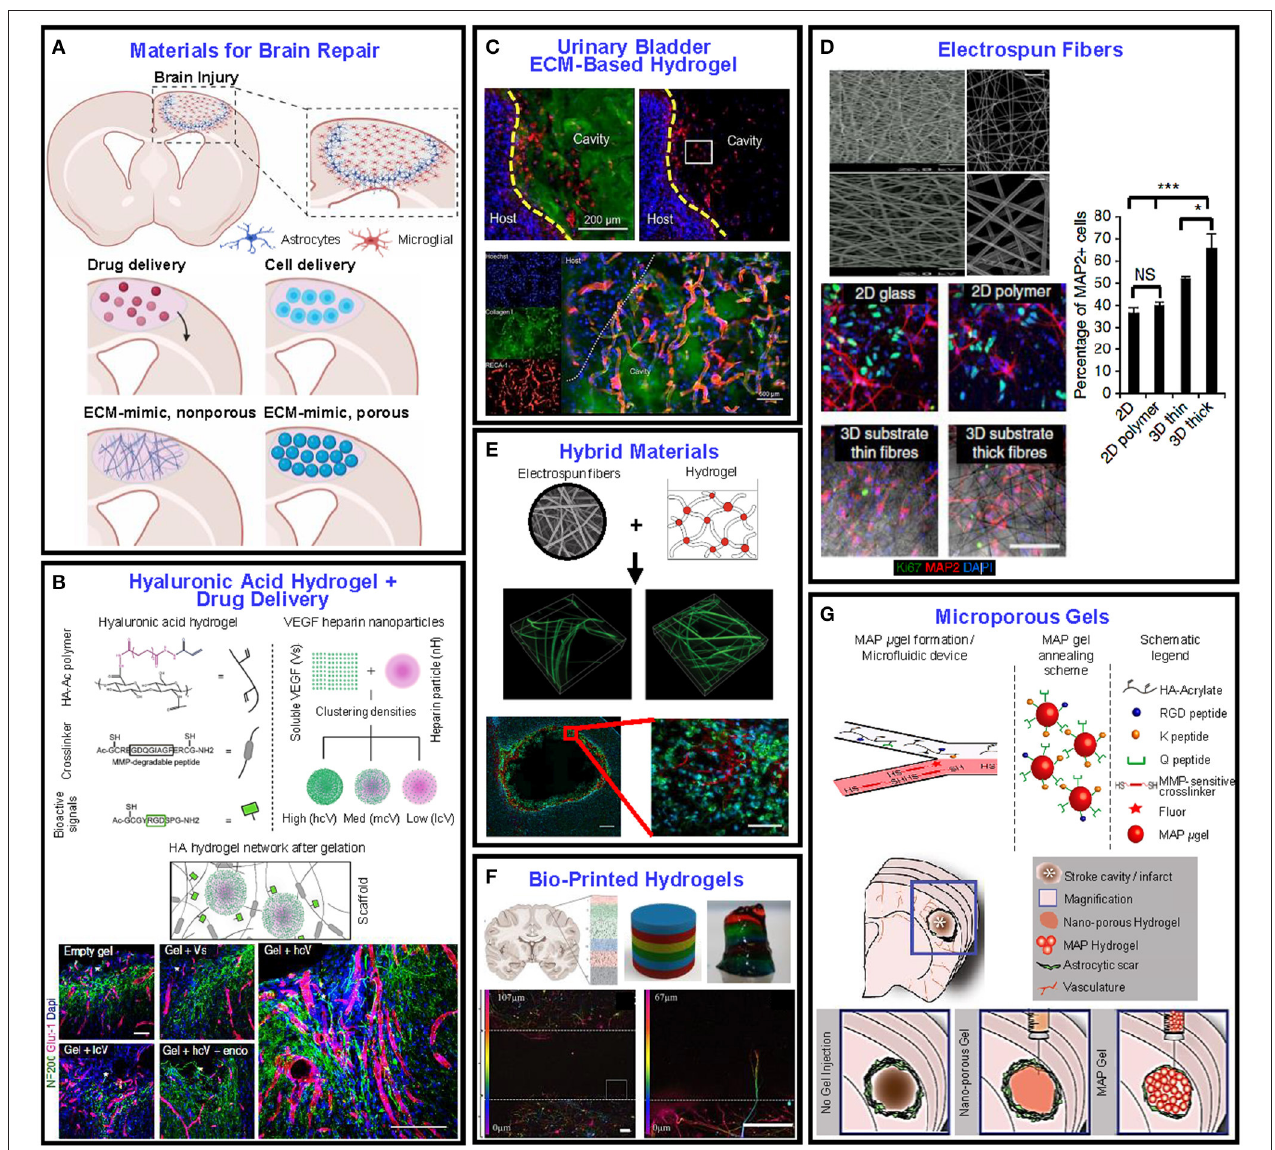
FIGURE 8 | Examples of recent advances in biomaterial scaffolds developed for brain tissue repair after injury. (A) Schematic illustration of the pathophysiology after brain injury illuminating the development of astrogliosis and the increase of the microglial density. (B) Design of HA with clustered VEGF on heparin NPs. The immunostained images of neurons and vessels show that the gel with high clustered VEGF delivery enhanced angiogenesis and neurogenesis (Nih et al., 2018). (C) Urinary bladder-based hydrogel. The immunostained images illustrating ECM hydrogel and cell nucleus show that the hydrogel modulated neuroinflammation and enhanced neurogenesis and angiogenesis (Ghuman et al., 2018). (D) Electrospun fibers with different architectures and porosities infiltrated with human-induced neuronal cell populations. Significantly higher numbers of human iN cells expressed microtubule-associated protein 2 in the thick fibrous scaffolds relative to the 2D controls and thin fibrous scaffolds (Carlson et al., 2016). (E) Fibers incorporated in hydrogels. When implanted into the striatum, the scaffold displayed higher cellular infiltration and a more loosely defined glial boundary. The images show the tissue-scaffold interface—astrocytes (red), macrophages/microglia (green), and cell nuclei (labeled with DAPI, blue) (Rivet et al., 2015). (F) Bio-printed brain-like layer structures (each color represents a different layer). Confocal microscope images of neurons in different layers, colored for the distribution of cells through the z -axis, showing an axon penetrating the adjacent layer (Lozano et al., 2015). (G) Schematic illustration of the production of hydrogel microparticles in a flow-focusing microfluidic device (Nih et al., 2017). These gels can be injected at the location of interest while preserving their